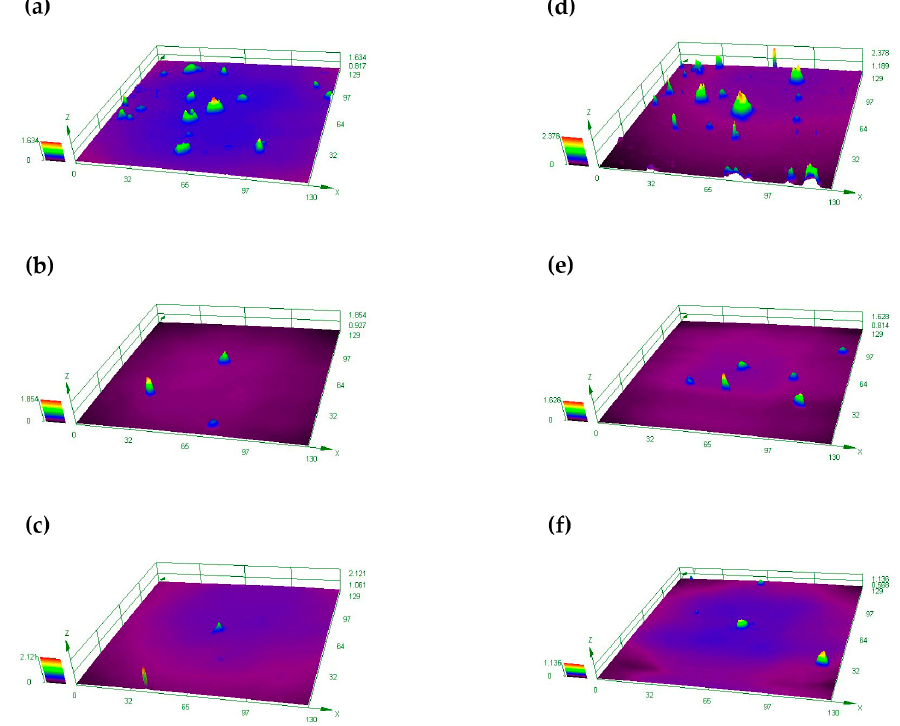
Figure 13. LSCM images of the TFTC line. ( a ) The bottom of the TFTC left line; ( b ) The middle of the TFTC left line; ( c ) The top of the TFTC left line; ( d ) The bottom of the TFTC right line; ( e ) The middle of the TFTC right line; ( f ) The top of the TFTC right line.